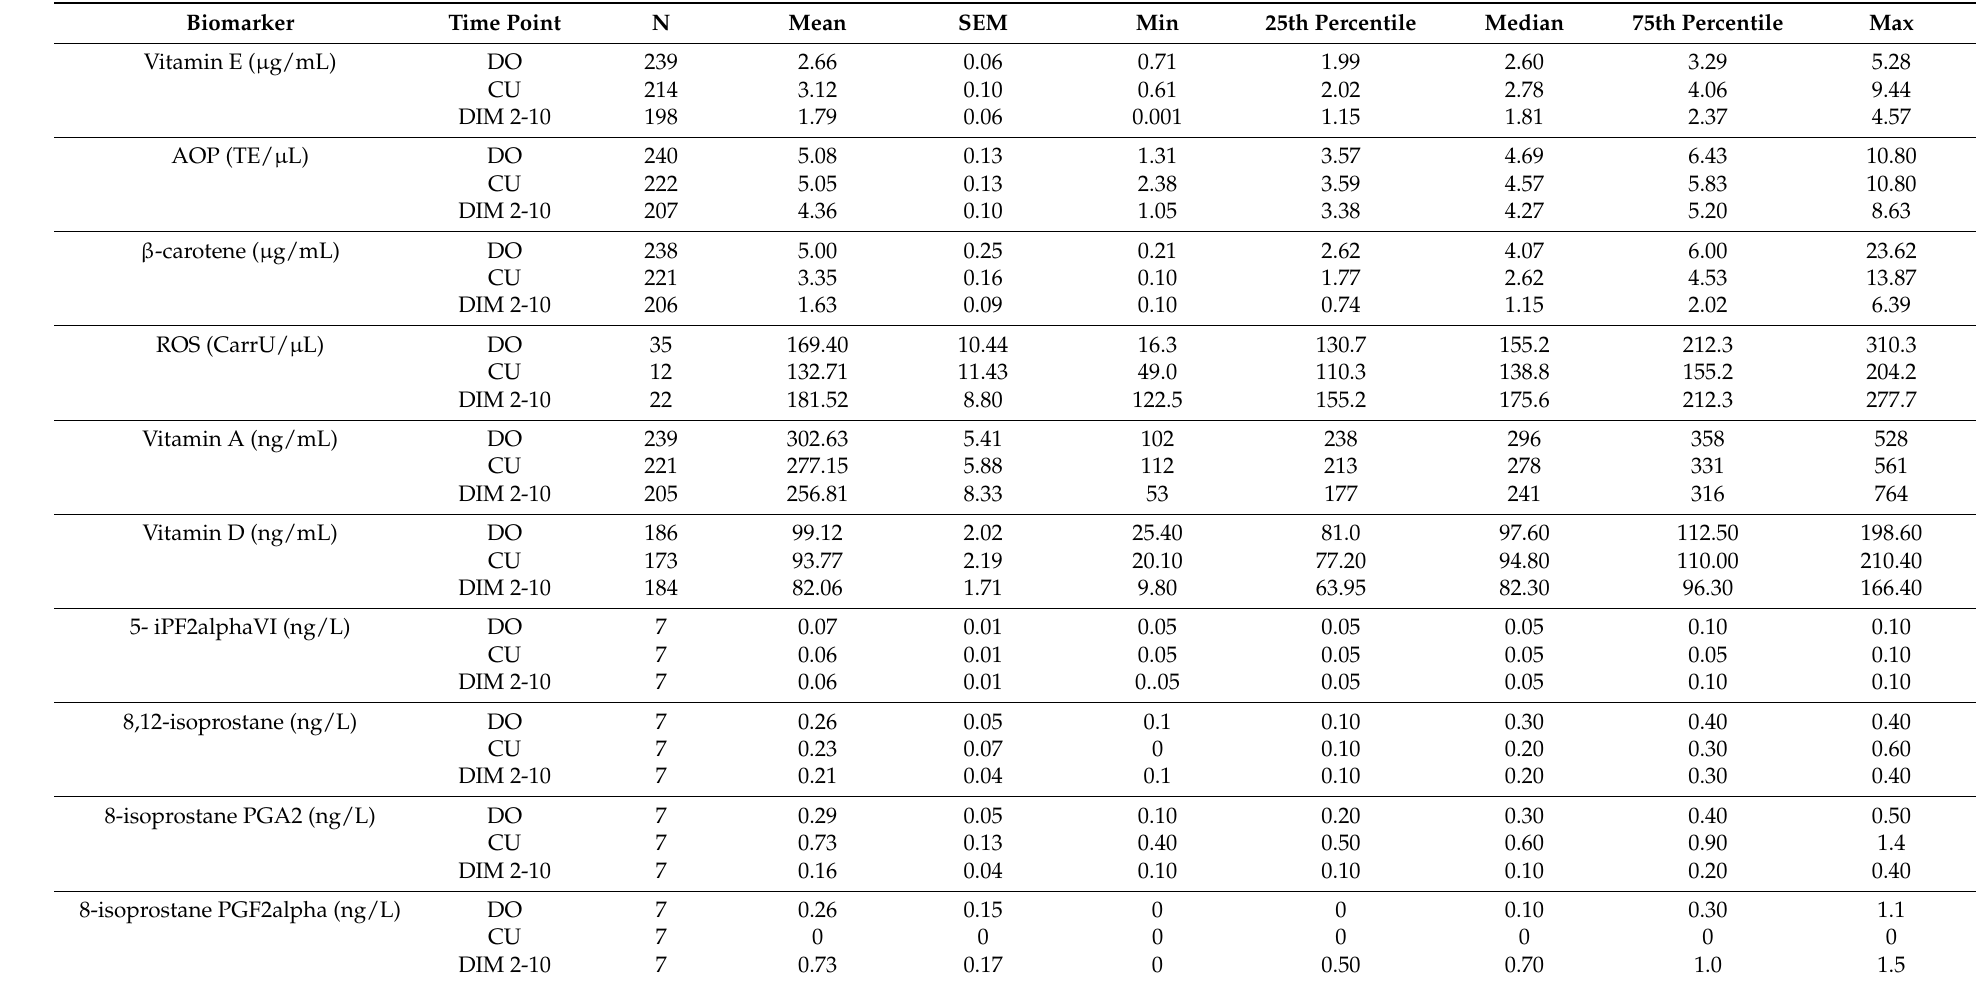
Table 2. Summary statistics of oxidative stress biomarkers and vitamins by time point (N = 240